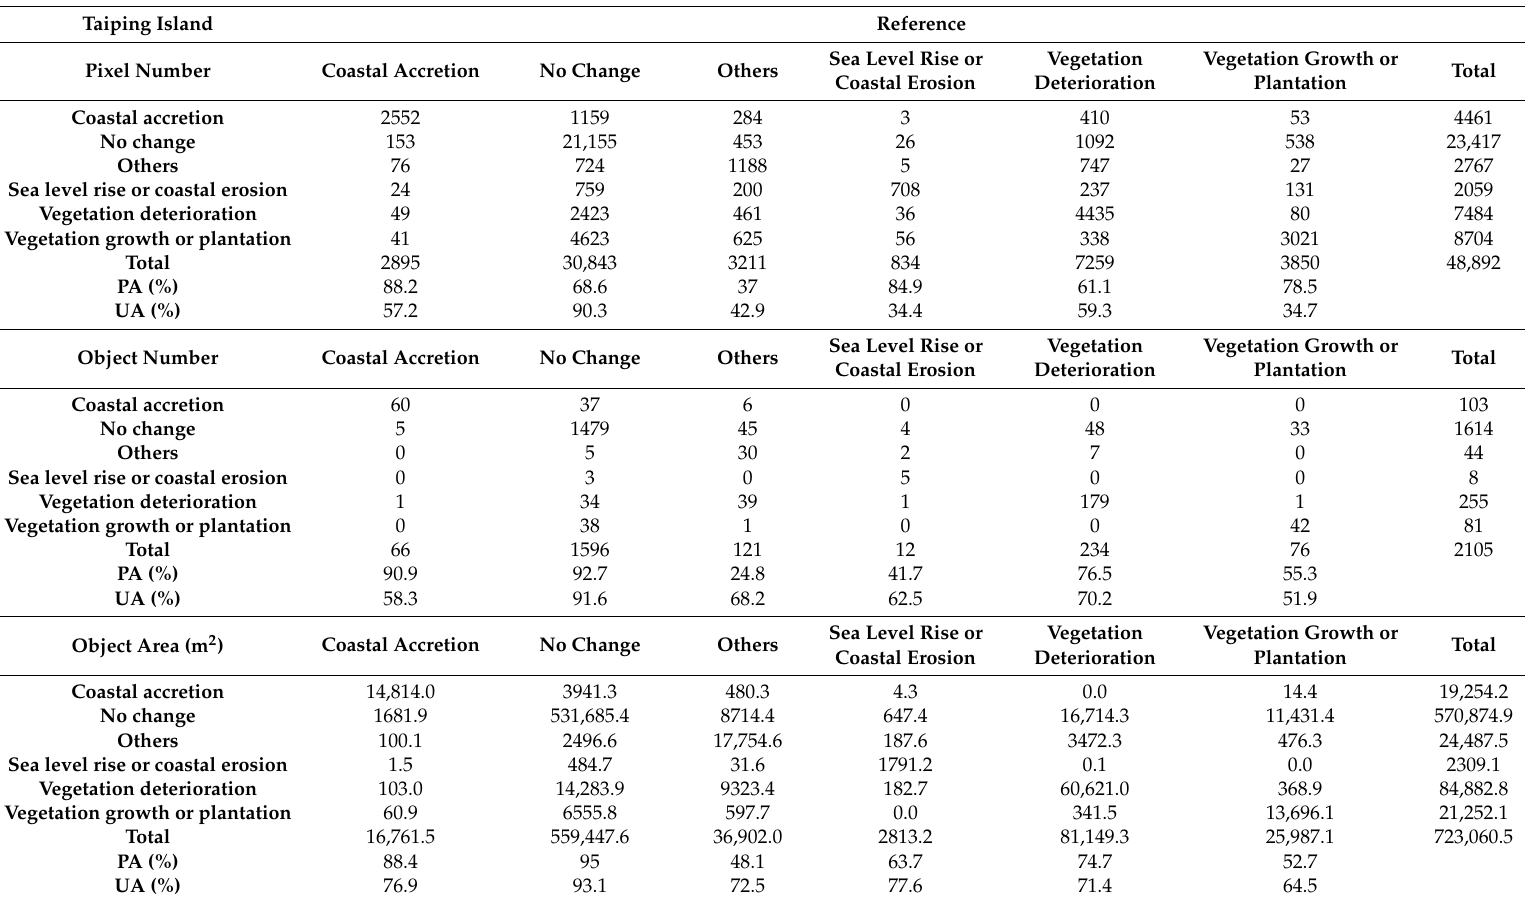
Table 5. Confusion matrices of PBCD and OBCD results for Taiping